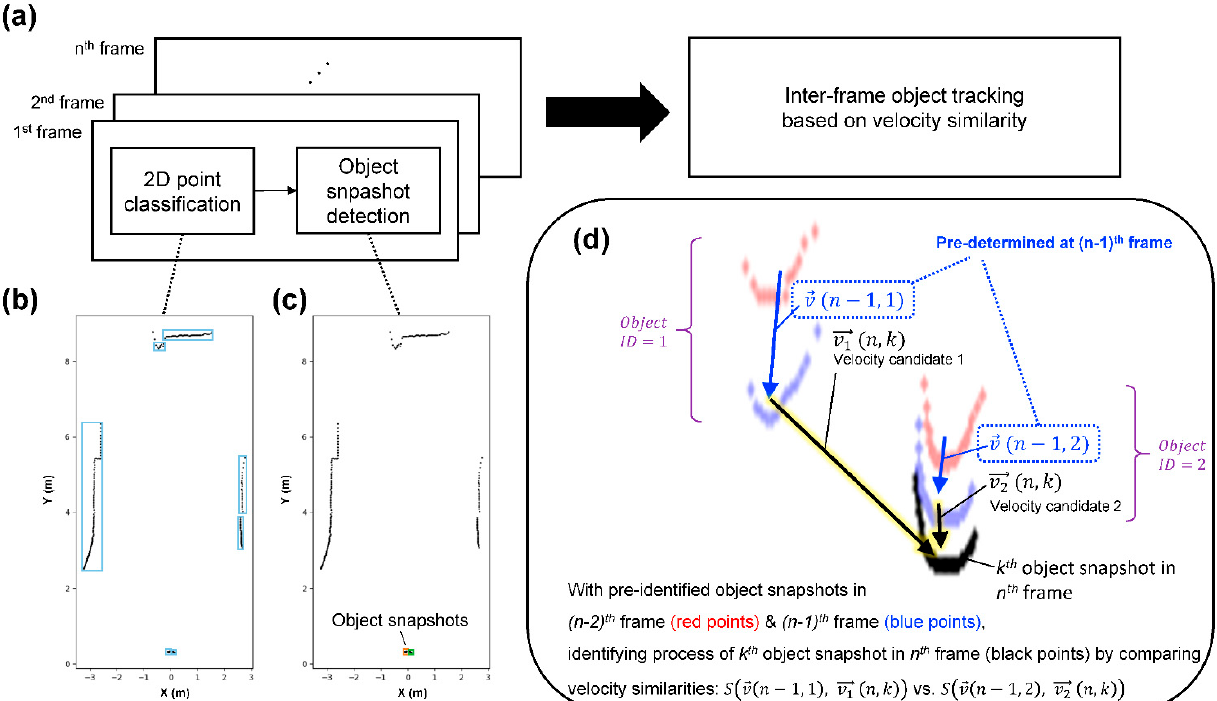
Figure 2. Concept of object tracking algorithm for 2D-LiDAR sensor. ( a ) Simplified flow chart of inertia-based object tracking algorithm (IOTA) (see Supplementary Figure S13 for full version). ( b ) Point groups represented as bounding boxes after point classification. ( c ) Point groups are filtered out by object size and curvature criteria to remove background. ( d ) An example case of inter-frame object tracking where probable velocity candidates, 𝑣 (cid:2869) (cid:4652)(cid:4652)(cid:4652)(cid:4652)⃗(𝑛, 𝑘) and 𝑣 (cid:2870) (cid:4652)(cid:4652)(cid:4652)(cid:4652)⃗(𝑛, 𝑘) , of the k th object snapshot in the n th frame are compared to the predetermined velocities , 𝑣⃗(𝑛 − 1, 1) and 𝑣⃗(𝑛 − 1,2) , of object ID 1 and 2 in the (n − 1) th frame.